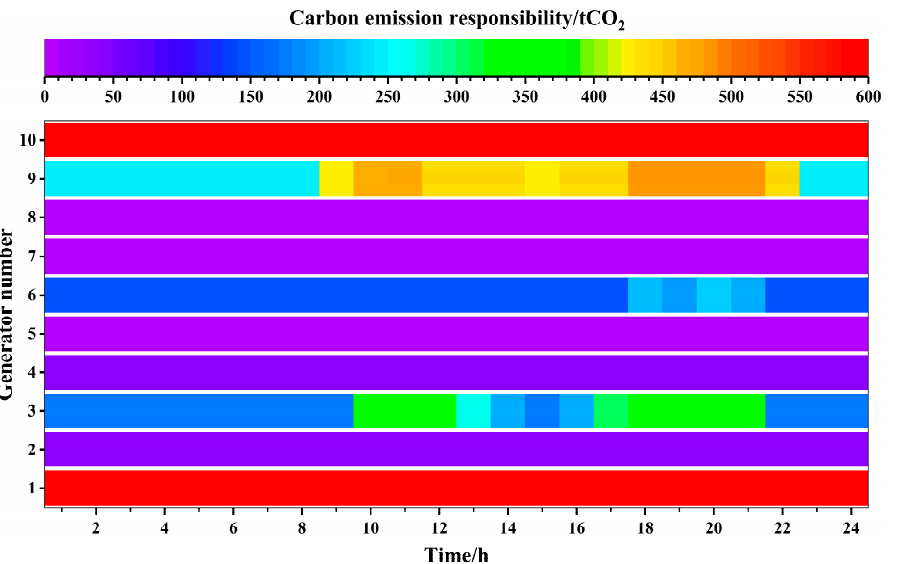
Figure 4. Carbon-emission responsibilities of 10 generators allocated via Aumann–Shapley method.